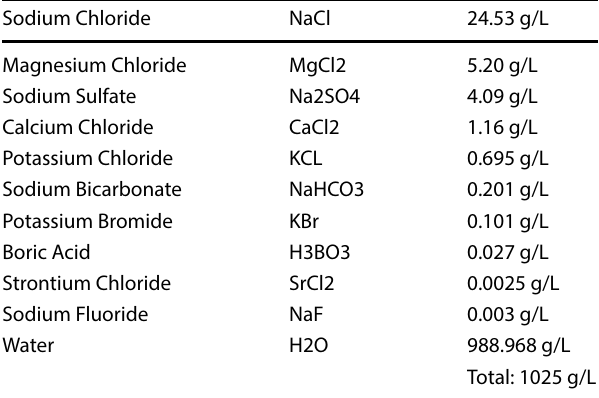
Fig. 6 a , b. High-pressure compacted rectangular blocks compressed at 2000 kN (1–4), along with regular low-pres- sure cement compressed at 25–30 N (LP, middle), before curing ( a ) and a sliced cube with 6.0 wt% of virgin carbon/ glass fibers before compres- sion testing ( b )